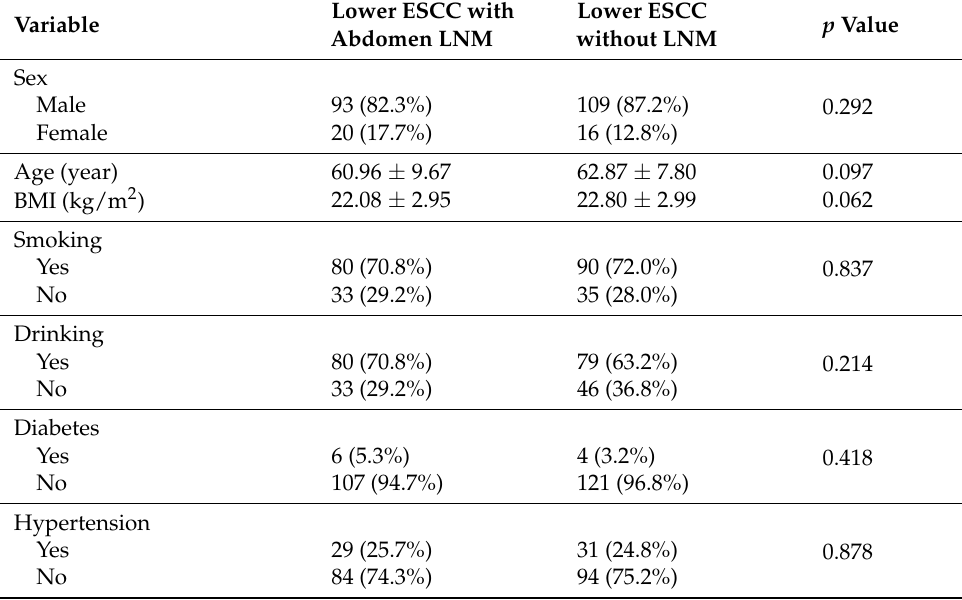
Table 4. Characteristics of patients with abdominal LNM and without LNM in lower